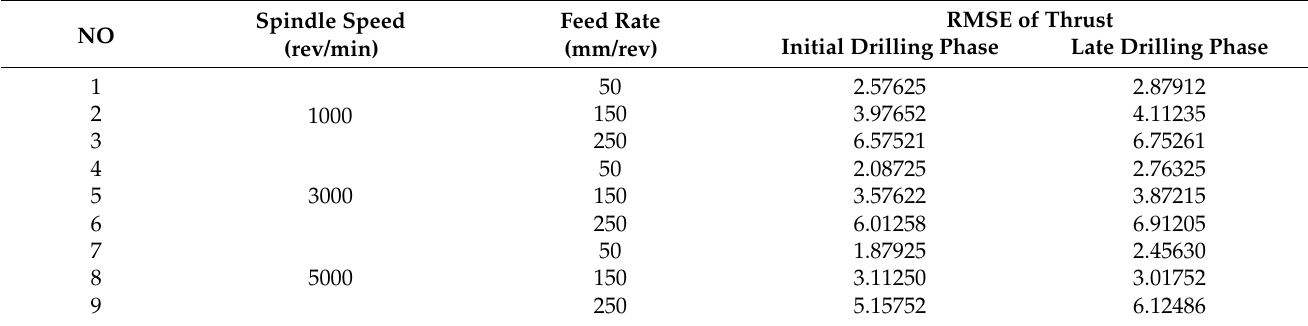
Table 9. The RMSE values of thrust during different stages under different